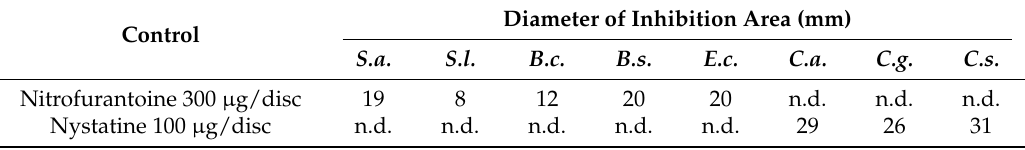
Table 2. Diameter of inhibition area (mm) of nitrofurantoine and nystatine.